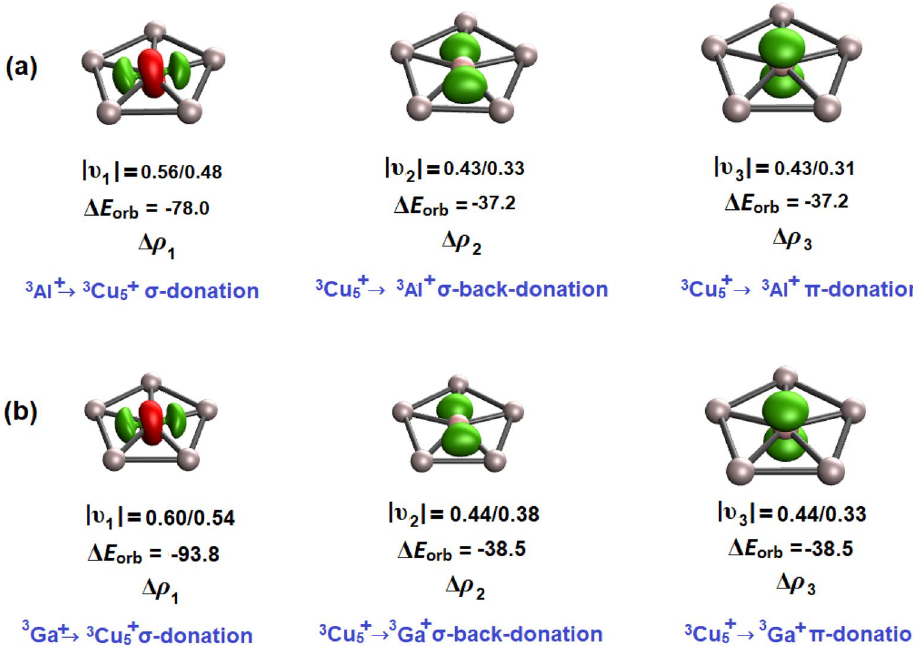
Figure 5. Plot of deformation density, Δρ obtained from ETS-NOCV analysis using Al + and Ga + (triplet) and Cu 5 + in triplet state for ( a ) Cu 5 Al 2+ and ( b ) Cu 5 Ga 2+ clusters. Orbital values are given in kcal/mol. |υ| represents the (alpha/beta) charge eigenvalues. The direction of charge flow is red → green. Cut-off employed, Δρ = 0.004.